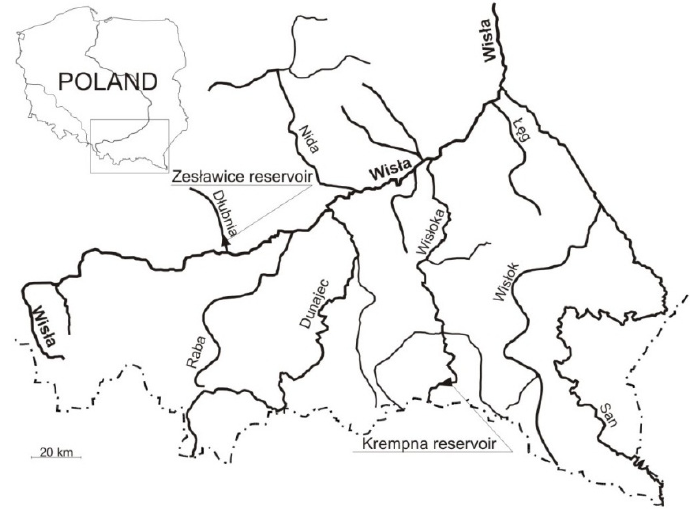
Figure 1. Location of the analyzed